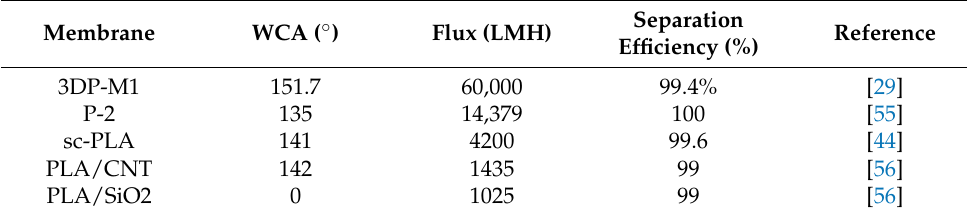
Table 2. Comparison of 3DP-M1 performance with conventional membranes.